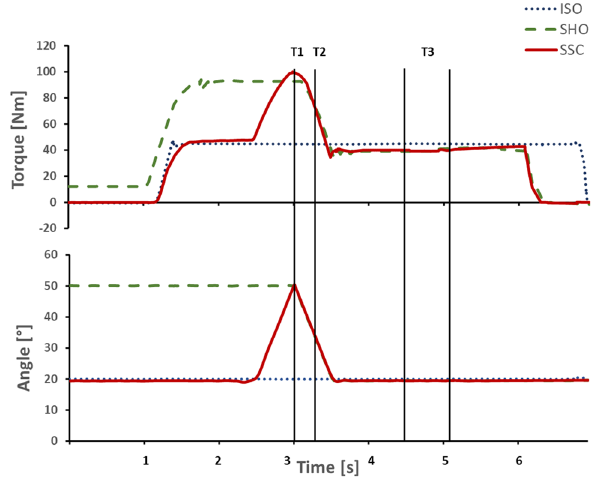
Figure 2. Exemplary representation of torque-time and dynamometer angle-time traces. The dotted blue line represents ISO, the dashed green line SHO and the continuous red line SSC. The vertical lines indicate the timepoint of data analysis, with T1 being end of stretch, T2 midpoint of shortening and T3 the steady-state interval where the mean torque was